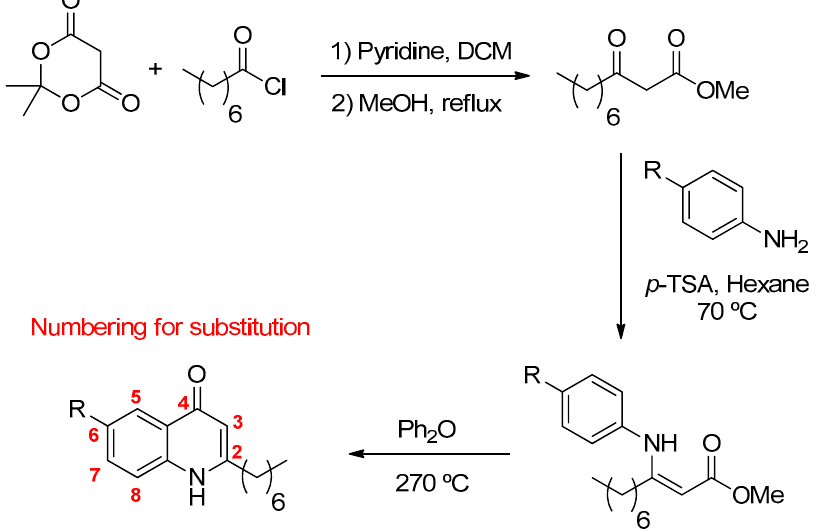
Figure 1. Quinolones synthesis. The β -keto-ester, methyl-3-oxodecanoate was prepared by acylation of Meldrum’s acid (2,2-dimethyl-1,3-dioxane-4,6-dione) with octanoyl chloride, which was followed by methanolysis. Condensation of the β -keto-ester with the corresponding aniline in the presence of p-toluene sulfonic acid using a Dean-Stark apparatus and subsequent Conrad-Limpach cyclisation of the enamine at reflux in diphenyl ether gave the corresponding 2-heptyl-4-quinolone.